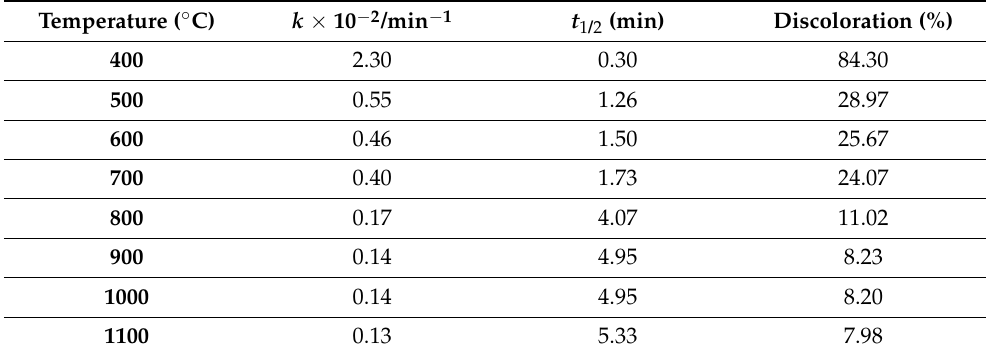
Table 4. Thee experimental photocatalytic data of the decolorization of the rhodamine B solution from the heat-treated CuFe 2 O 4